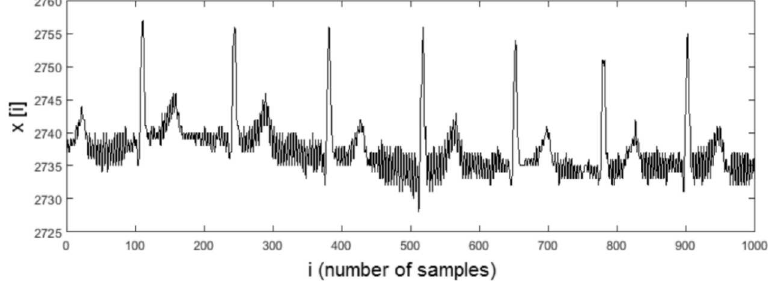
Figure 1. Raw EHG signal